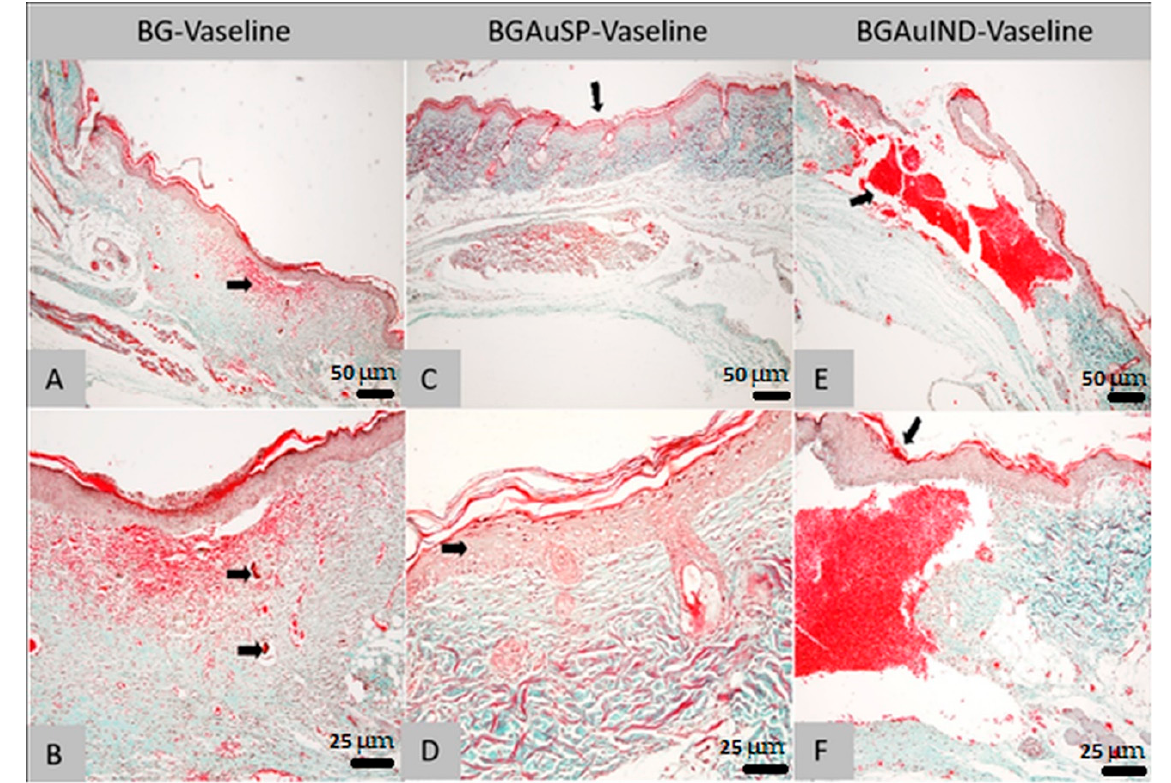
Figure 9. Histological findings of skin: the aspect of the skin in the area of the cutaneous defect; dermal granulation tissue with associated bleeding (arrow; Goldner trichrome col., ob. 4×) from the animals treated with BG-Vaseline ( A , B ), BGAuSP-Vaseline ( C , D ) and BGAuIND ( E , F ). A —Skin appearance in the area of skin defect; dermal granulation tissue with associated hemorrhage (arrow; trichrome Goldner-magnification, ob. 10×). B —Skin: completely regenerated epidermis, with the presence of some subepidermal spaces; In the dermis, granulation and hemorrhage tissue are identified, respectively the presence of an acidophilic-amorphous material without inflammatory reaction at the interface area with it (arrows; trichrome Goldner-magnification, ob. 10×). C —Skin: the aspect of the skin in the area of the cutaneous defect (arrow; Goldner trichrome col., ob. 10×). D —Skin: slight acanthosis (arrow) epidermis on the recuperative background and the presence of relatively well-differentiated connective tissue (Goldner trichrome col., ob. 40×). E —Skin: general aspect in the area of the defect (arrow), with sub epidermal hemorrhage (col. Goldner trichrome; ob. 4×). F —Skin: regenerated epidermis covering the defect area (arrow); discrete leukocyte infiltrate in the marginal areas of the defect (Goldner trichrome col., ob. 20×).